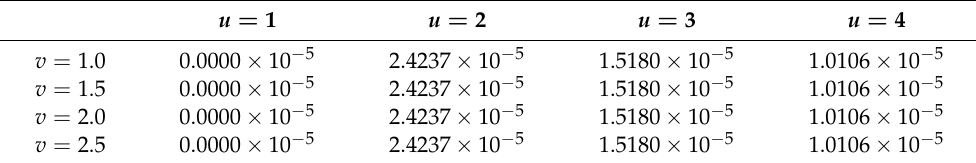
Table 7. The absolute error of expected value E [ X T ] with different parameters u and v .